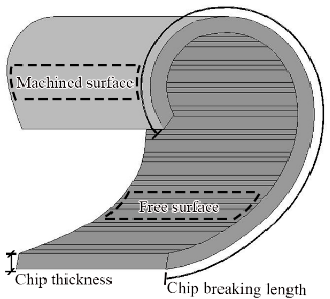
Figure 4. Chip parameters including machined surface, free surface, chip breaking length, and chip thickness.